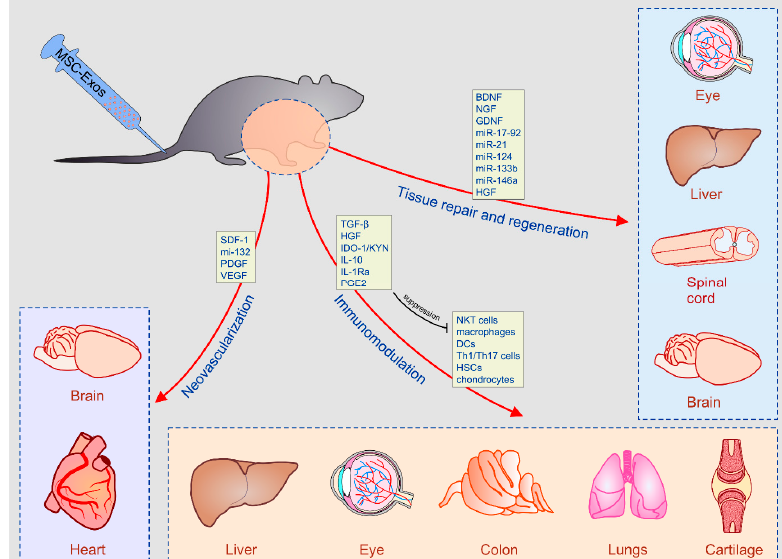
Figure 7. Molecular mechanisms responsible for beneficial effects of MSC-derived secretome in tissue repair and regeneration. Results obtained in experimental studies suggest that MSC-derived secretome represents a promising therapeutic tool for the treatment of degenerative and inflammatory diseases. Beneficial effects of MSC-sourced secretomes rely on their capacity to deliver neurotrophins (brain-derived neurotrophic factor (BDNF), nerve growth factor (NGF), hepatocyte growth factor (HGF), miR-17-92, miR-21, miR-124, miR-133b, miR146a which enable regeneration of injured liver, brain, spinal cord and eye. MSC-derived secretomes contain immunomodulatory factors which inhibit proliferation and activation of inflammatory immune cells and promote expansion of immunosuppressive cells resulting in alleviation of inflammation-related tissue injury. MSC-sourced secretomes are enriched with angiomodulatory factors (stromal cell derived factor-1 (SDF-1), miR-132, platelet-derived growth factor (PDGF), vascular endothelial growth factor (VEGF)) that promote angiogenesis and neo-vascularization in ischemic regions of brain and heart enhancing survival of injured neurons and